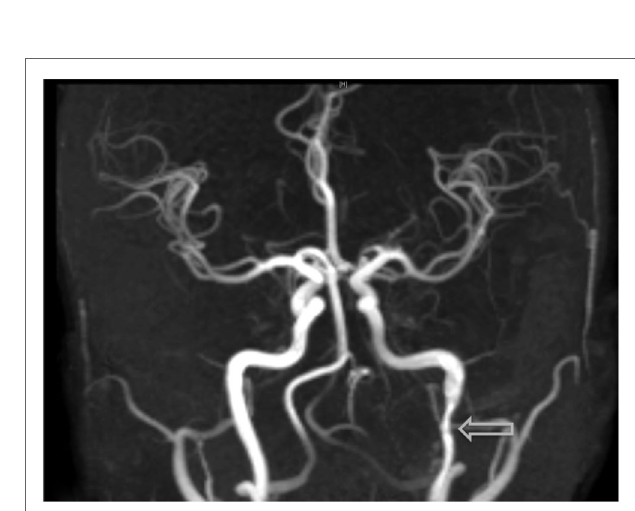
FIgURe 2 | Additional MRI angiography imaging revealing bilateral focal loss of flow-related enhancement in the distal cervical vertebral arteries with distal antegrade flow compatible with bilateral vertebral dissections with severe stenosis and antegrade collaterals.